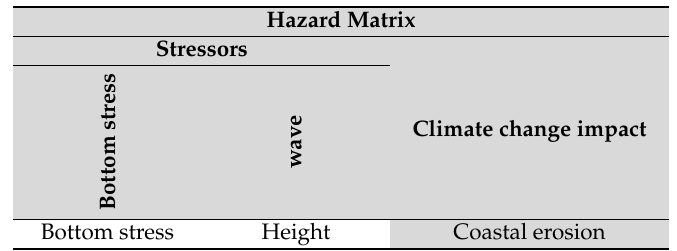
Table 1. Hazard matrix representing coastal erosion stressors and hazard metrics (light